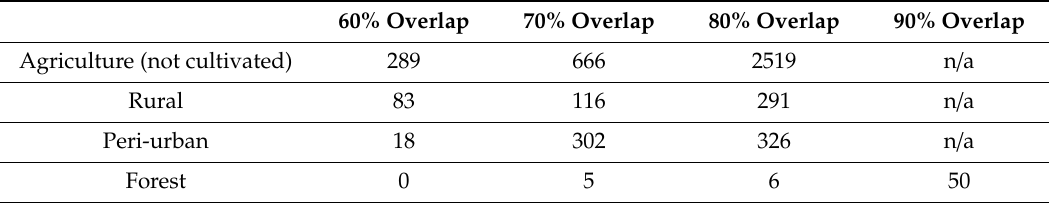
Table 4. Mean of automatic tie-points of image pairs using SURF showing di ff erent land use classes and